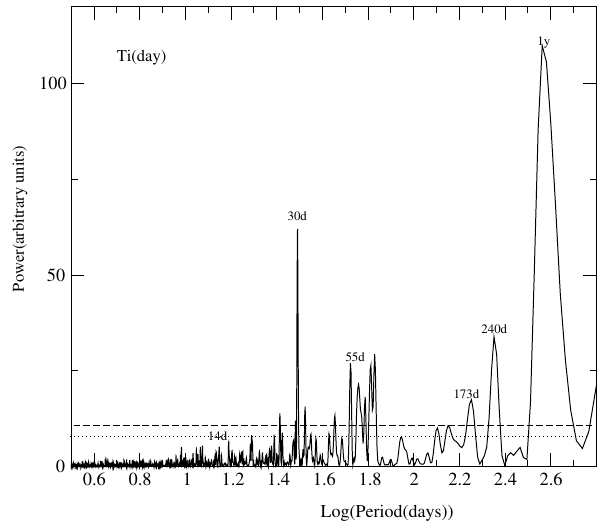
Fig. 5. Spectrum of daytime ion temperature. The numbers in the figure indicate the corresponding period in days. Confidence levels same as in Fig. 1.